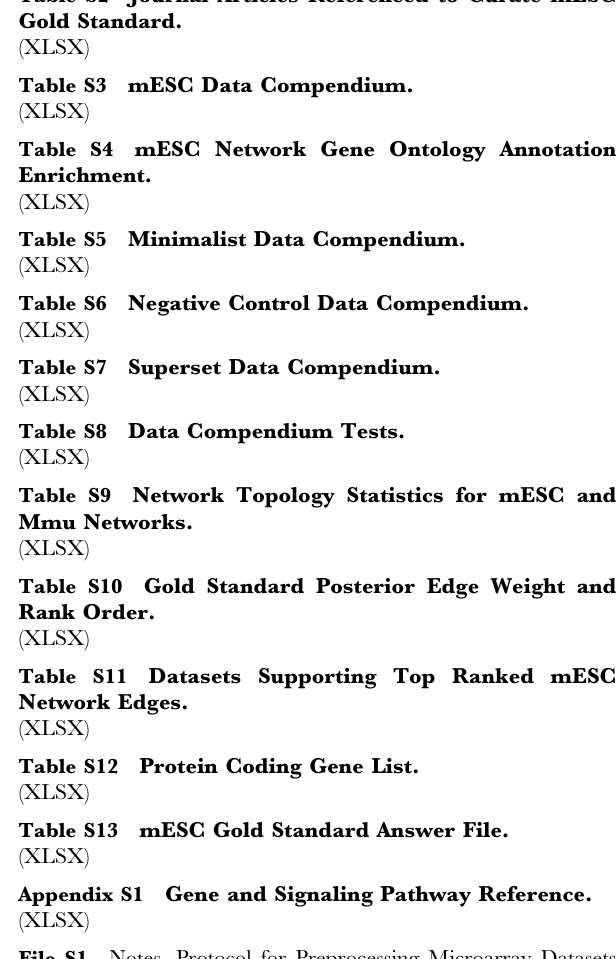
Figure S1 mESC Network Performance Evaluation through Cross Validation. Figure S2 Effect of Regularization on mESC and Test Networks. Figure S3 Dataset Classes Supporting Top mESC Network Edges. Figure S4 Data Compendium Tests. Figure S5 Datasets Supporting Tdh Connectivity to Gold Standard Genes.